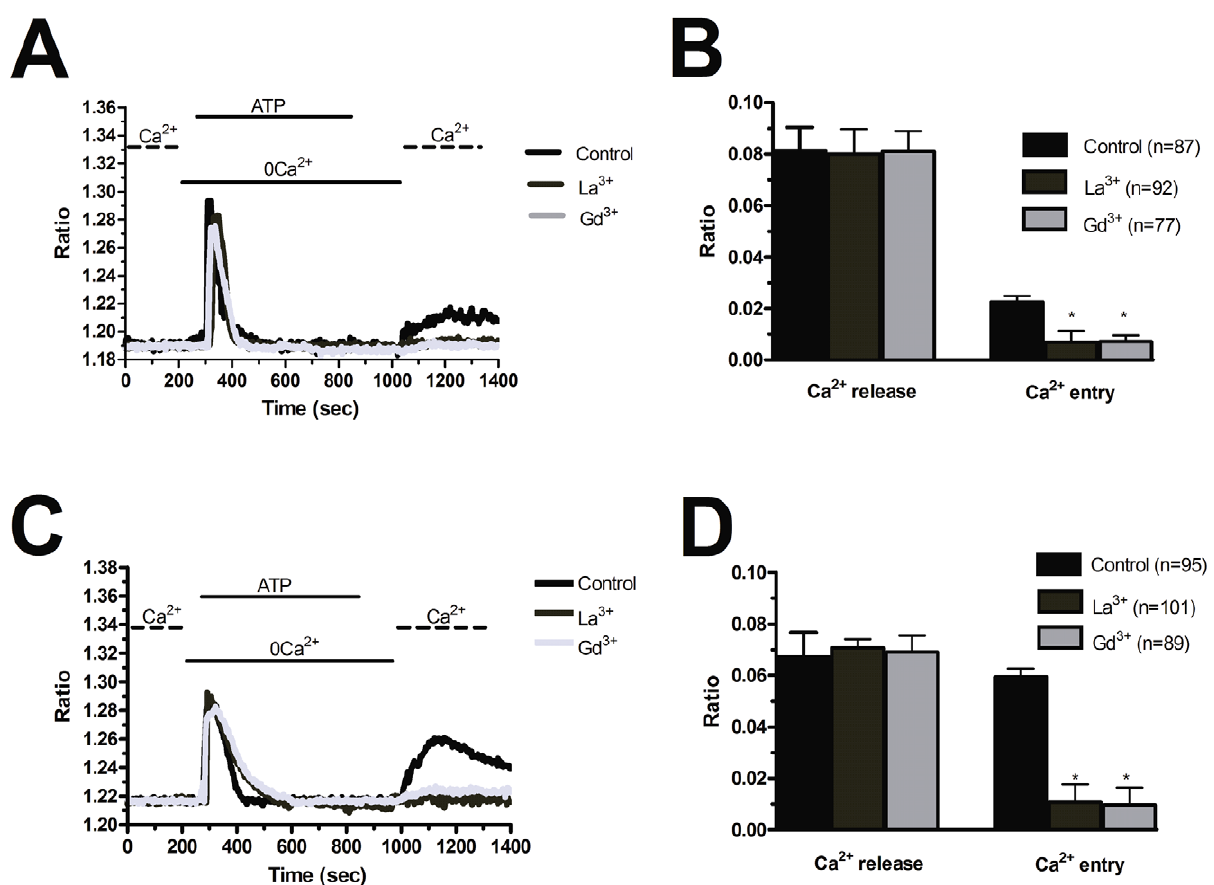
Figure 7. La 3 + and Gd 3 + suppress store-operated Ca 2 + entry stimulated by ATP in endothelial progenitor cells. La 3 + (10 m M) and Gd 3 + dampen SOCE triggered by ATP (100 m M) in both N-EPCs (A) and RCC-EPCs (B). The traces are representative of the experiments conducted on EPCs from at least three different donors for each condition. Mean 6 SE of the amplitude of ATP-induced Ca 2 + release and ATP-induced SOCE in the absence and presence of each trivalent cation in both N-EPCs (C) and RCC-EPCs (D). The asterisk indicates p , 0.05.